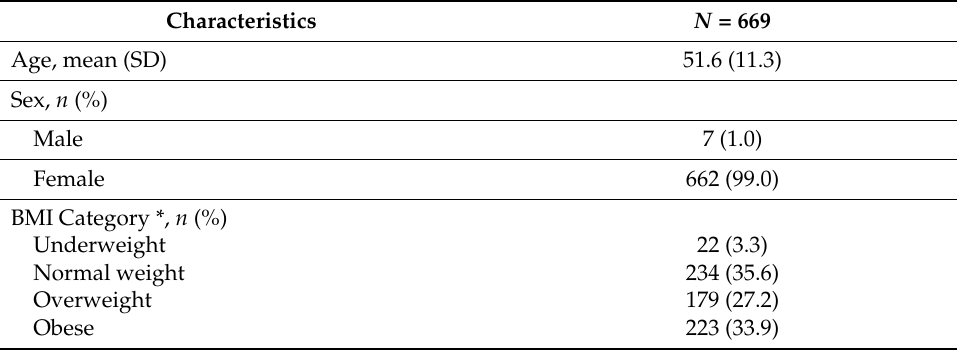
Figure 1. Number of Study Participants by US State. Note: Map created using the Datawrapper application (https://app.datawrapper.de (accessed on 2 March 2023)). Table 1. Sample Demographic and Health Characteristics.